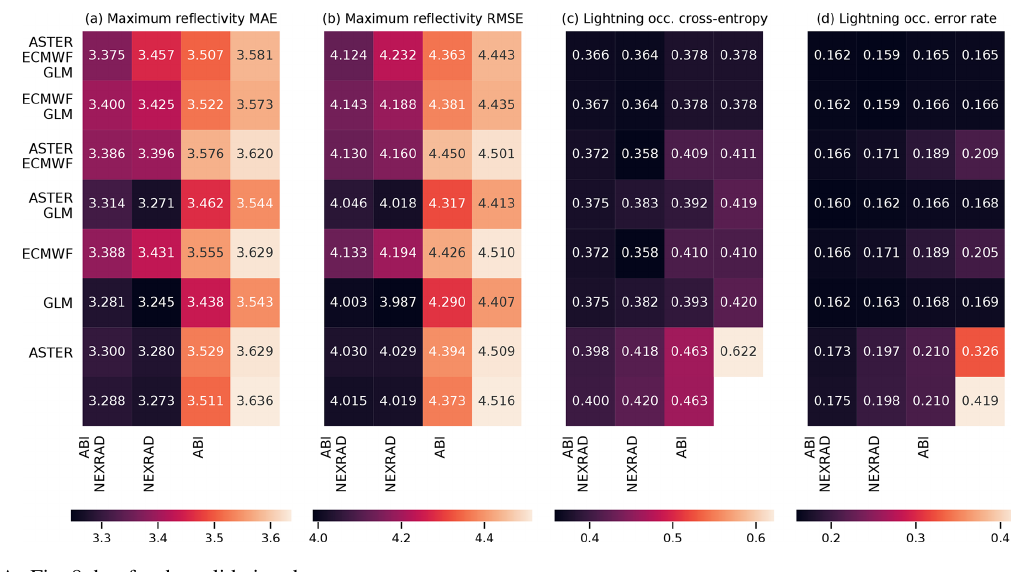
Figure A3. As Fig. 8, but for the validation dataset.